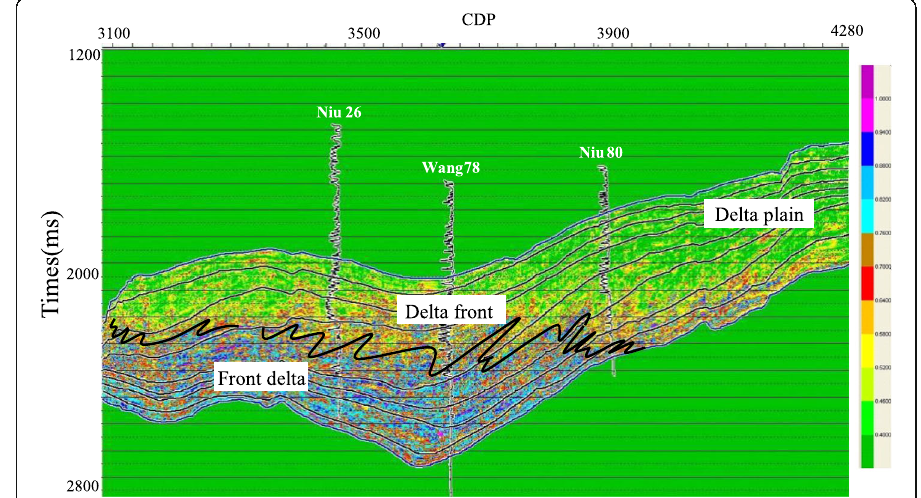
Fig. 5 Well section of the intermediate section in Member 3 of the Shahejie Formation in the Dongying Delta as obtained by multi-attribute SP